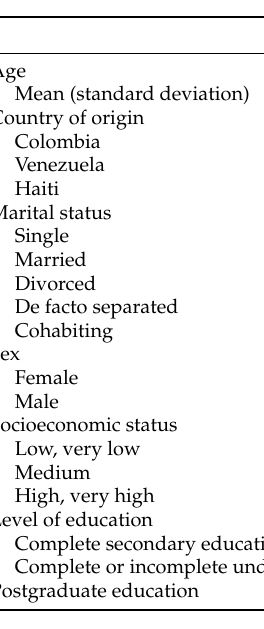
Table 1. Sociodemographic characteristics of the sample.